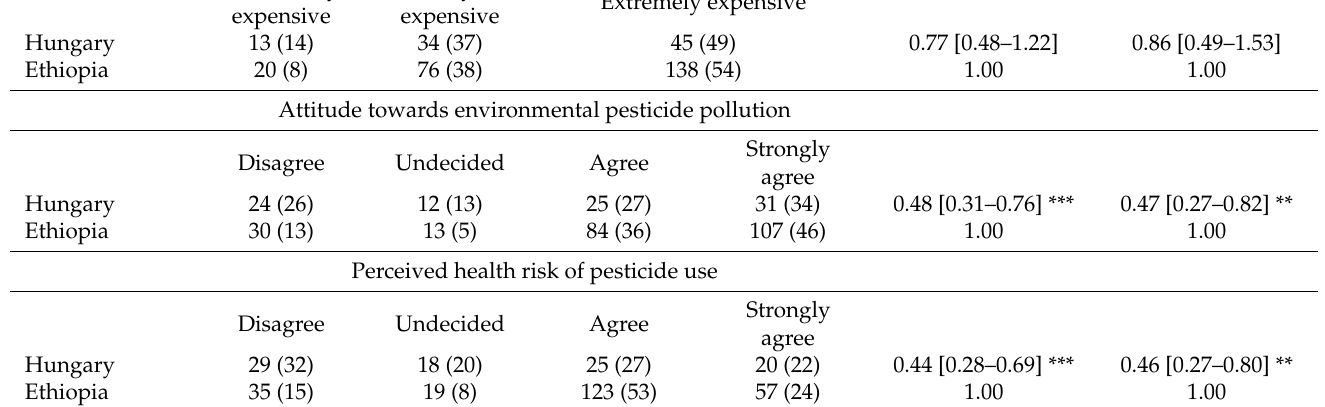
Table 8. Effect of nationality on the knowledge of and attitude to pesticides in Hungary and Ethiopia. Country Outcome Variables ( n = 326) Knowledge about pesticide products Poor